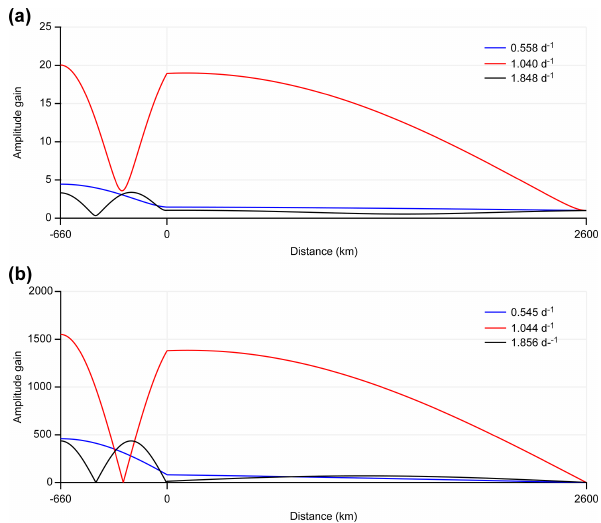
Figure 7. The amplitude gain as a function of x for different peak frequencies with friction (a) and without friction (b)